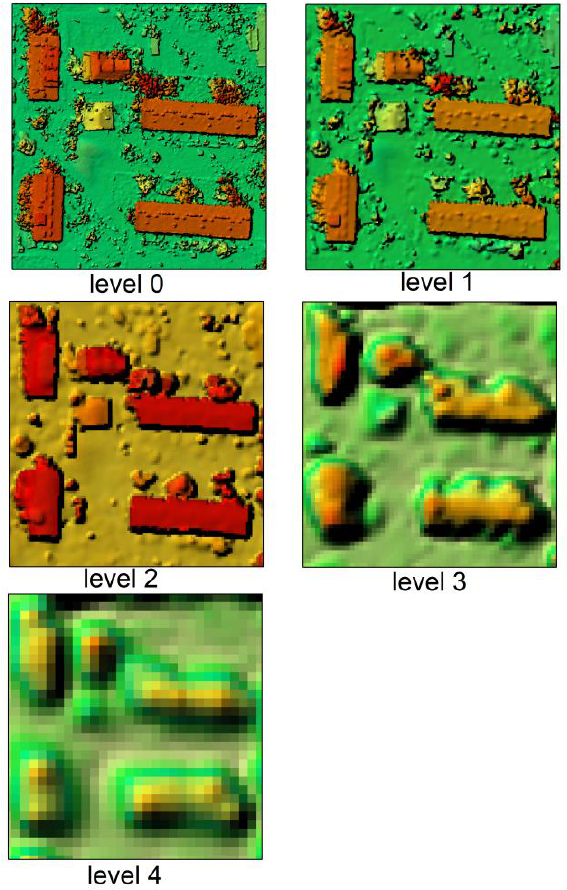
Figure 5. Comparison of DSMs generated from dense point clouds using different pyramid level